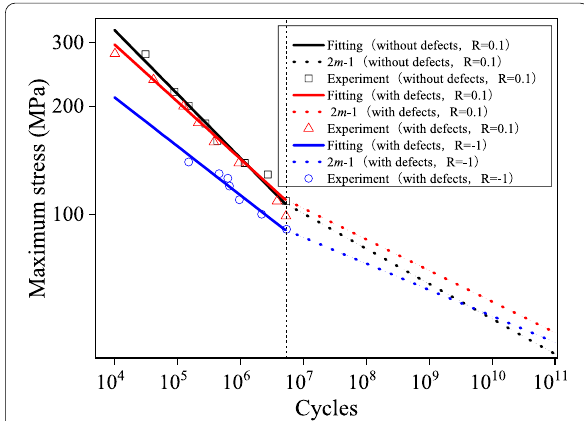
Figure 12 S–N curves of the cast aluminum alloy A357-T6, as obtained from experiments [30] with 2 m –1 approach